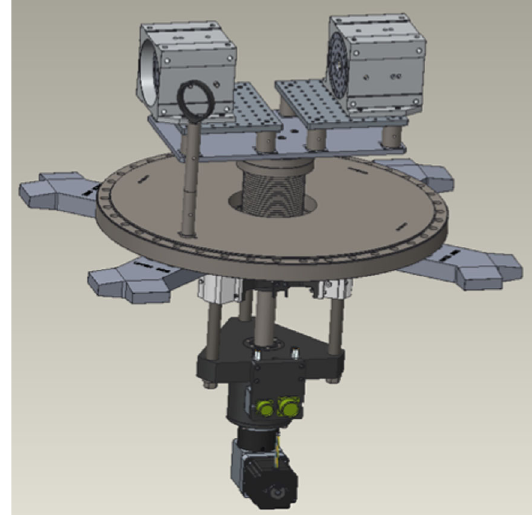
FIG. 17. Magnet system with the actuator assembled on the vacuum